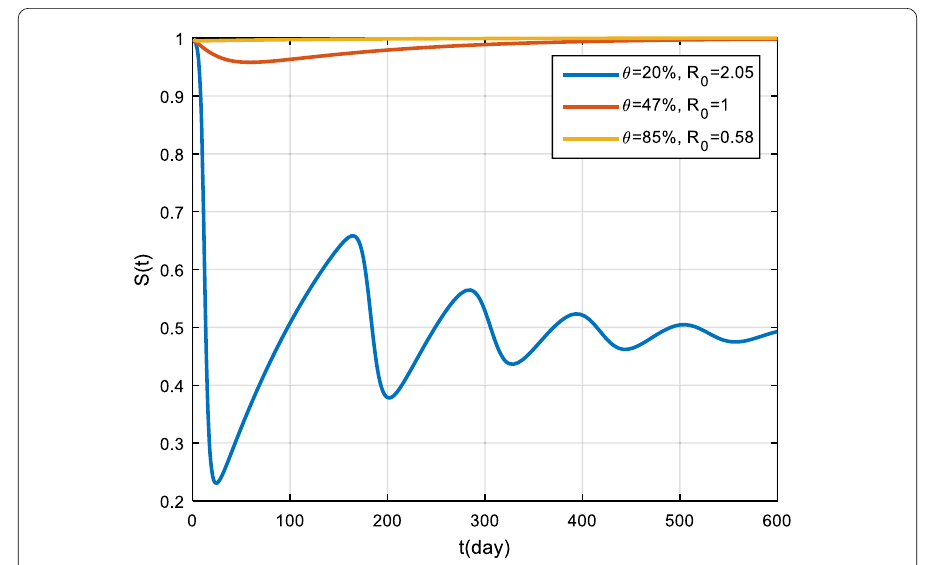
Figure 8 Variation in the number of suspected population for different values of θ